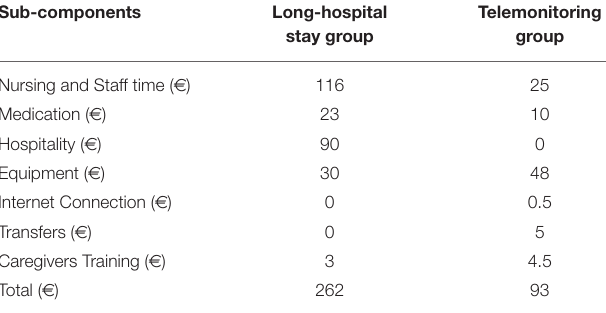
TABLE 4 | Components of daily health care